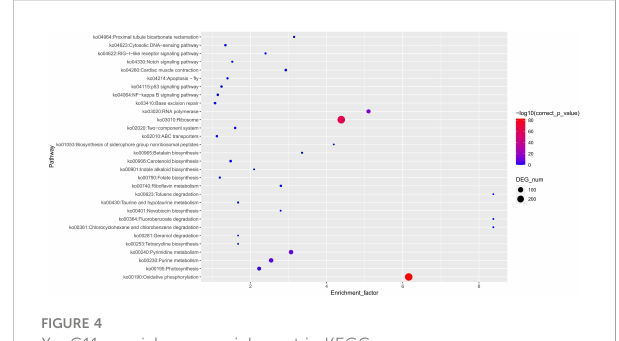
FIGURE 4 XsoG11 special gene enrichment in KEGG.